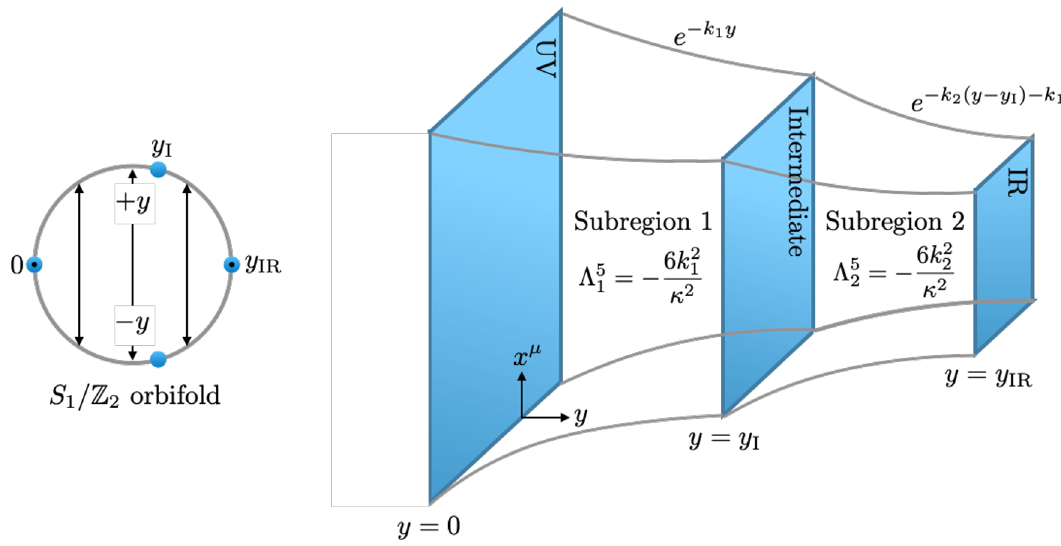
Figure 1 . Schematic pictures of the three 3-brane system. The left panel denotes the S 1 / Z 2 orbifold extra dimension where + y and − y are identified and y = { 0 , y IR } are the fixed points. The UV, intermediate and IR branes sit on y = { 0 , y I , y IR } , respectively. In the right panel, we refer to the bulk region between the UV and intermediate (intermediate and IR) branes as the subregion 1 (subregion 2 ). The bulk cosmological constants Λ 2 and the warp factors, e − k 1 y and 1 , 2 e − k 2 ( y − y I ) − k 1 y I , in the subregions 1 , 2 are different in